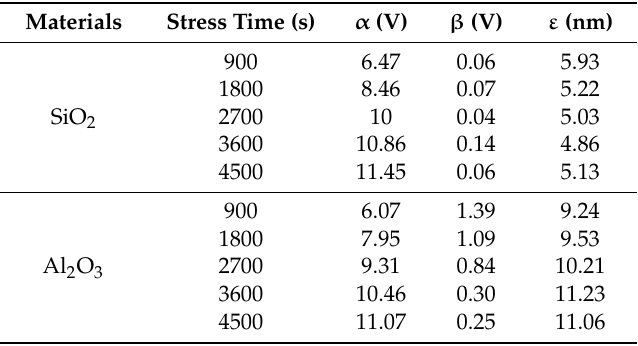
Table 1. Fitting parameters of the PV layers used for a-IGZO TFTs.